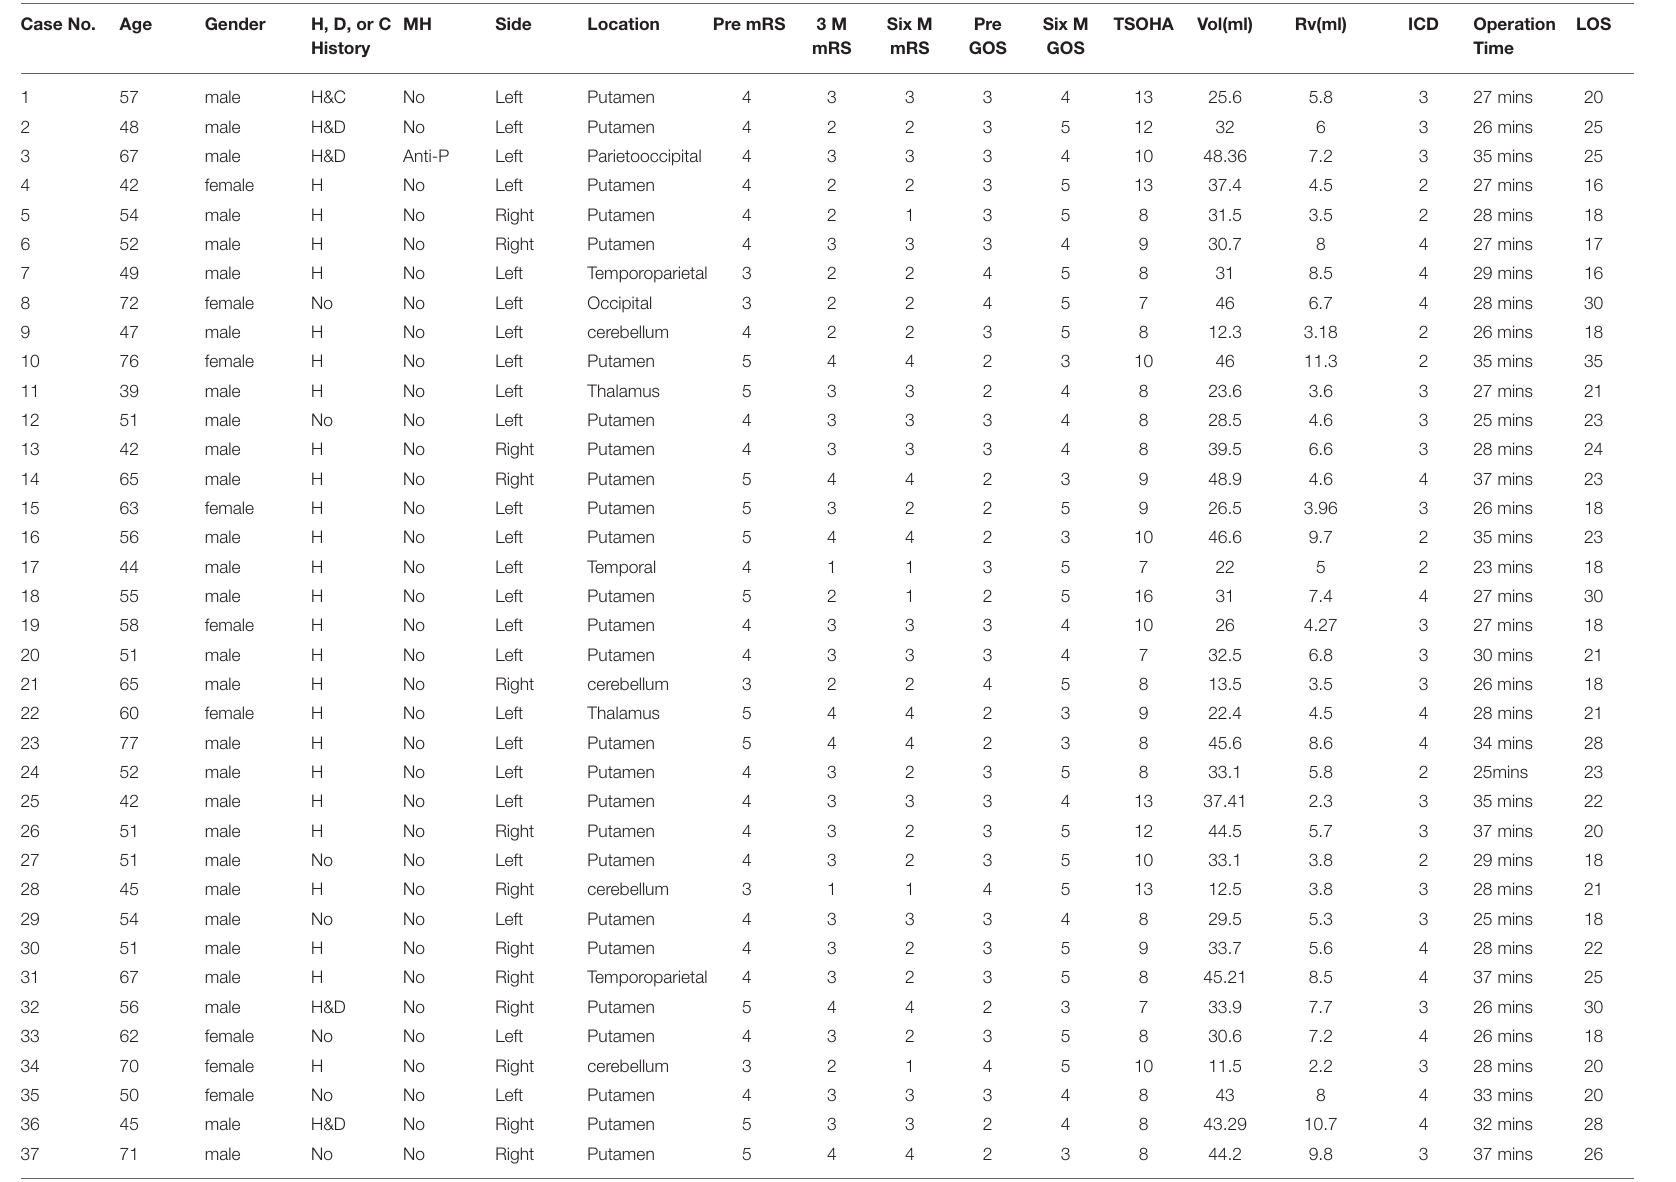
TABLE 1 | Demographic and clinical characteristics of the 45 patients in the study. Case No.